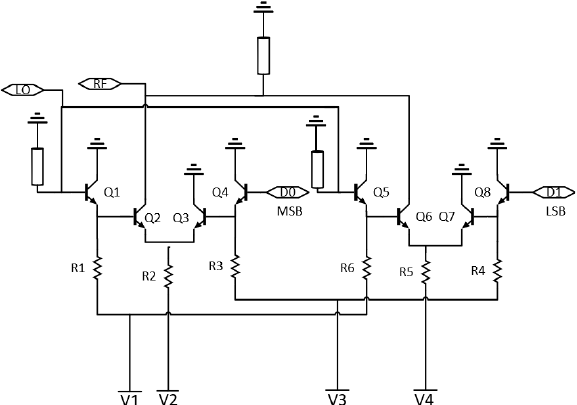
Figure 2. A simplified schematic of the proposed RF-DAC-based PAM-4 modulator.